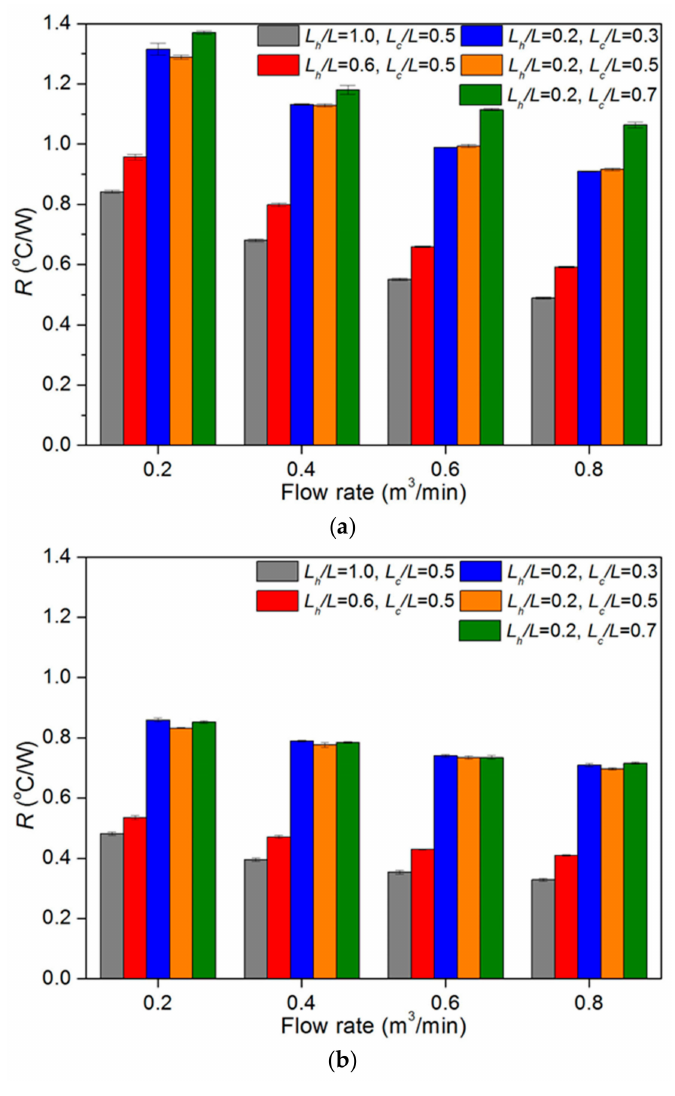
Figure 6. Thermal resistances. ( a ) w c = 7 mm; and ( b ) w c = 3